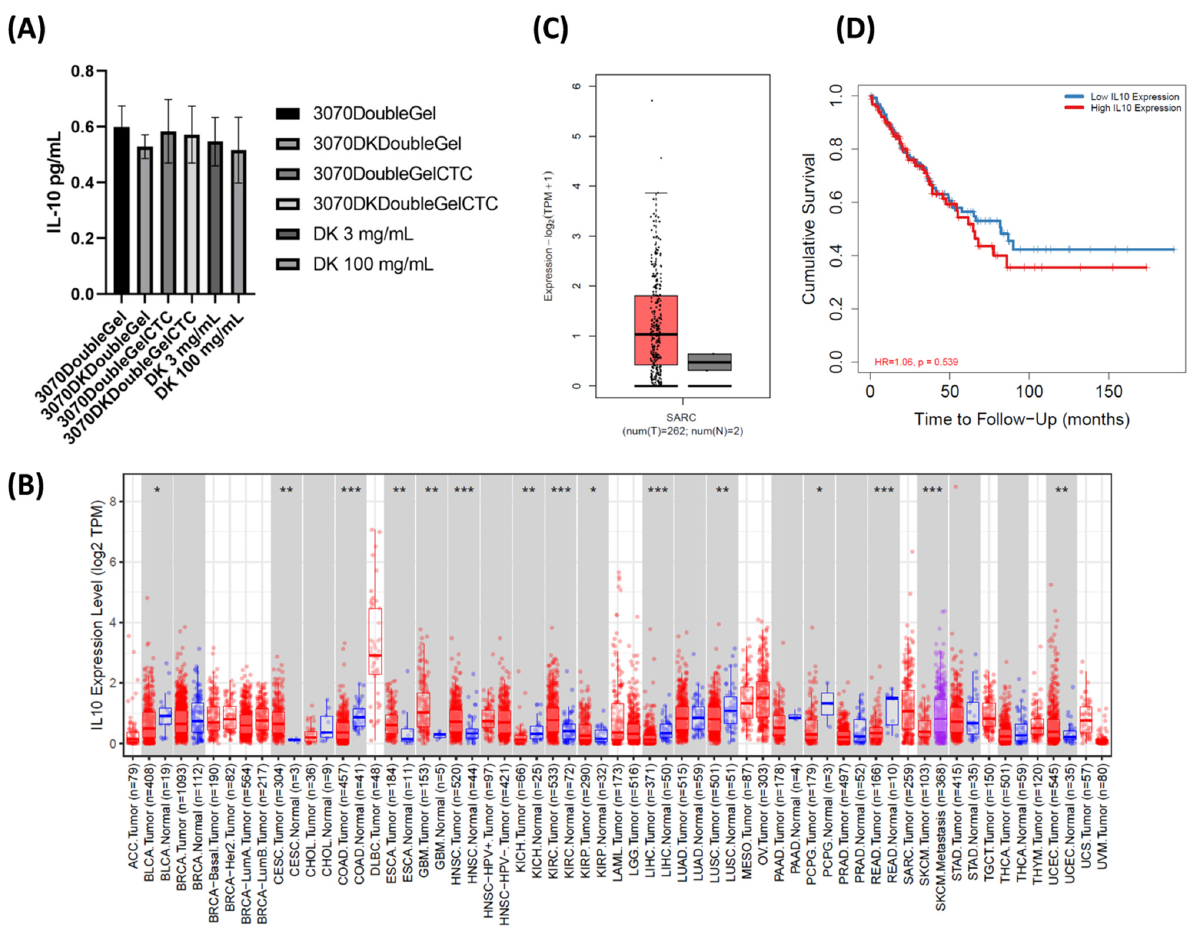
Figure 7. ( A ) IL-10 protein detection by using an ELISA assay in the supernatant of VA-ES-BJ human epithelioid sarcoma cell line in a transwell culture system (indirect co-culture) with3070DoubleGel, 3070DKDoubleGel, 3070DoubleGelCTC, 3070DKDoubleGelCTC, and positive control DK at both the concentration of 3mg mL − 1 (human plasma peak) and 100 mg mL − 1 (expected cumulative release from the device). ( B ) In silico analysis of IL-10 mRNA expression among tumors (red bar) and normal tissues (blue bar, reported when available), *: p -value < 0.05; **: p -value <0.01; ***: p -value <0.001. ( C ) IL-10 mRNA expression among 262 patients affected by sarcoma (red bar) and normal tissues (grey bar). ( D ) Kaplan–Meier curve of overall survival analysis based on the expression status of IL-10 in multiple cancer